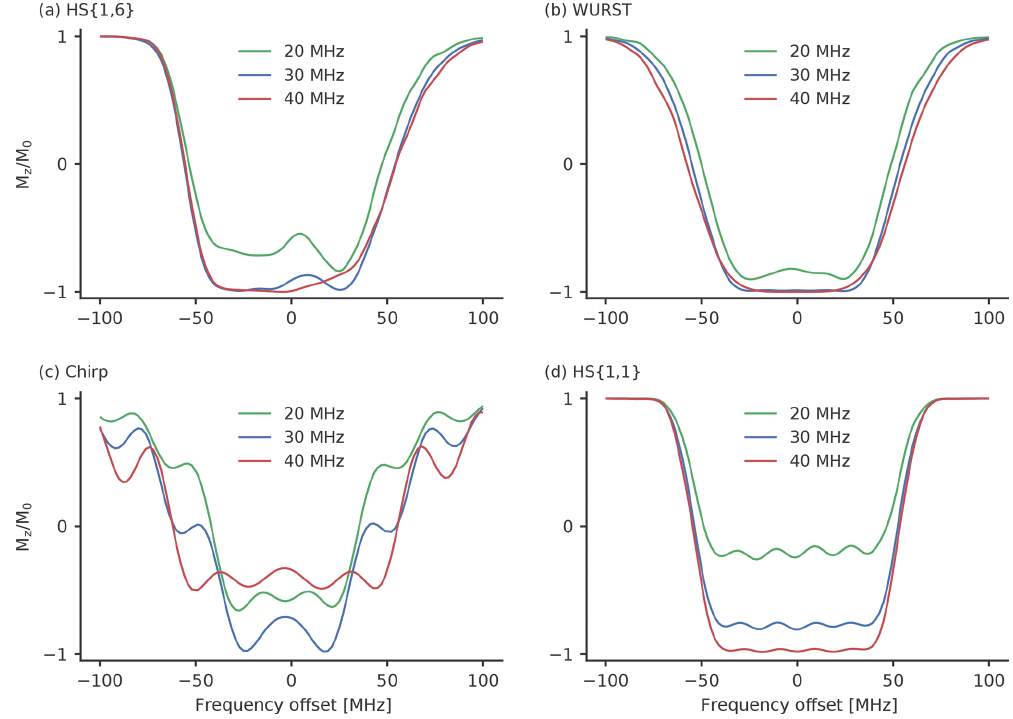
Figure 6. The inversion profiles of the best performing (a) HS { 1 , 6 } , (b) WURST, (c) chirp and (d) HS { 1 , 1 } pulses with the parameters from Table 3. They were simulated with a B 1 field strength of ν 1 = 20MHz (green), 30MHz (blue) and 40MHz (red). These field strengths correspond to π -pulse lengths of 25.0, 16.7 (which approximately corresponds to our setup) and 12.5ns. The B 1 field here is depicted as the Rabi frequency.